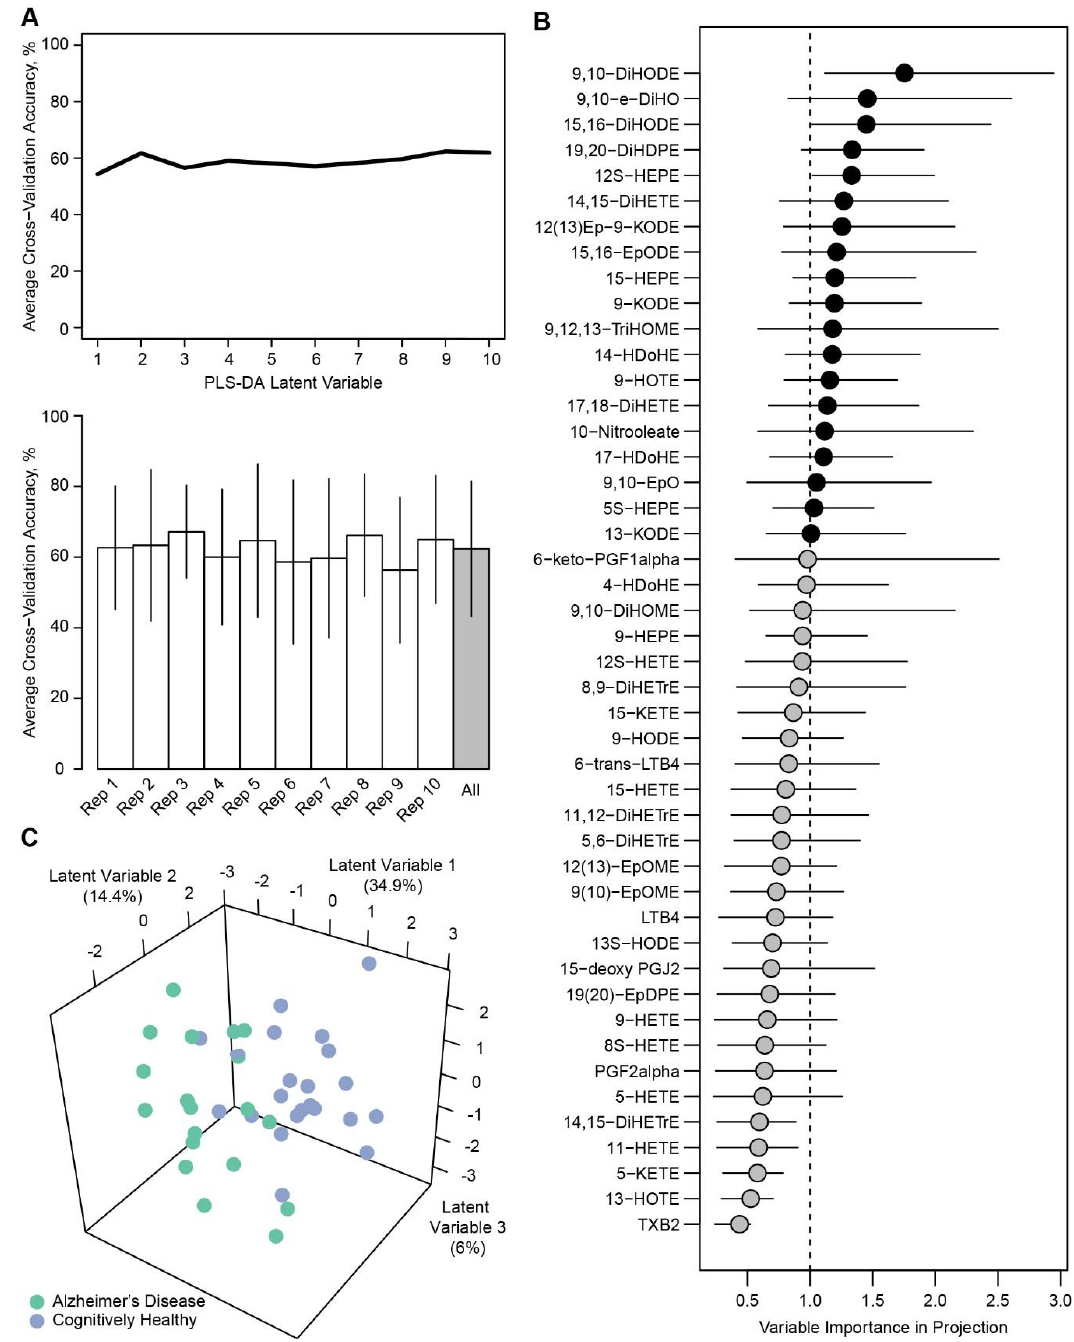
Figure 1. Modeling of Alzheimer’s disease (AD) status within type 2 diabetes (T2D) participants. ( A ) Cross-validation accuracy was 62.4% on average in cross-validation assessment. ( B ) Twenty-one metabolites had VIP scores > 1, with three metabolites having bootstrapped VIP confidence intervals > 1. ( C ) PLS-DA modeling with metabolites that had VIP > 1 had higher cross-validation accuracy, with separation of PLS-DA scores apparent with first three latent variables.